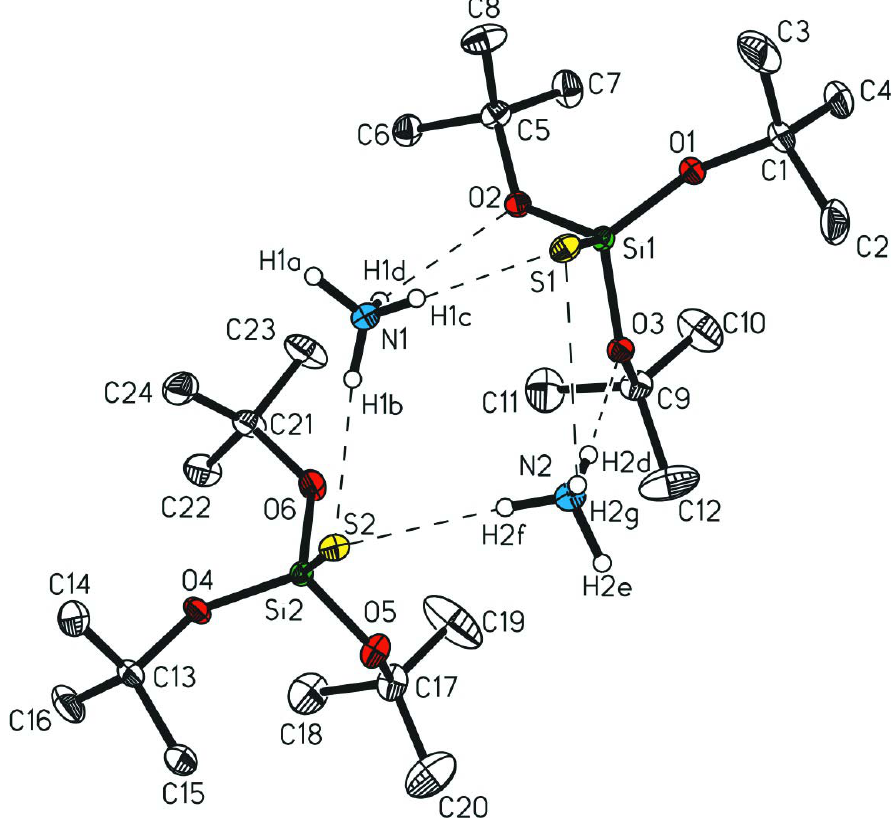
A view of the molecule of (I), showing the atom-labelling scheme. Displacement ellipsoids are drawn at the 30% probability level. All t Bu H atoms have been omitted for clarity. Hydrogen bonds are indicated with dashed